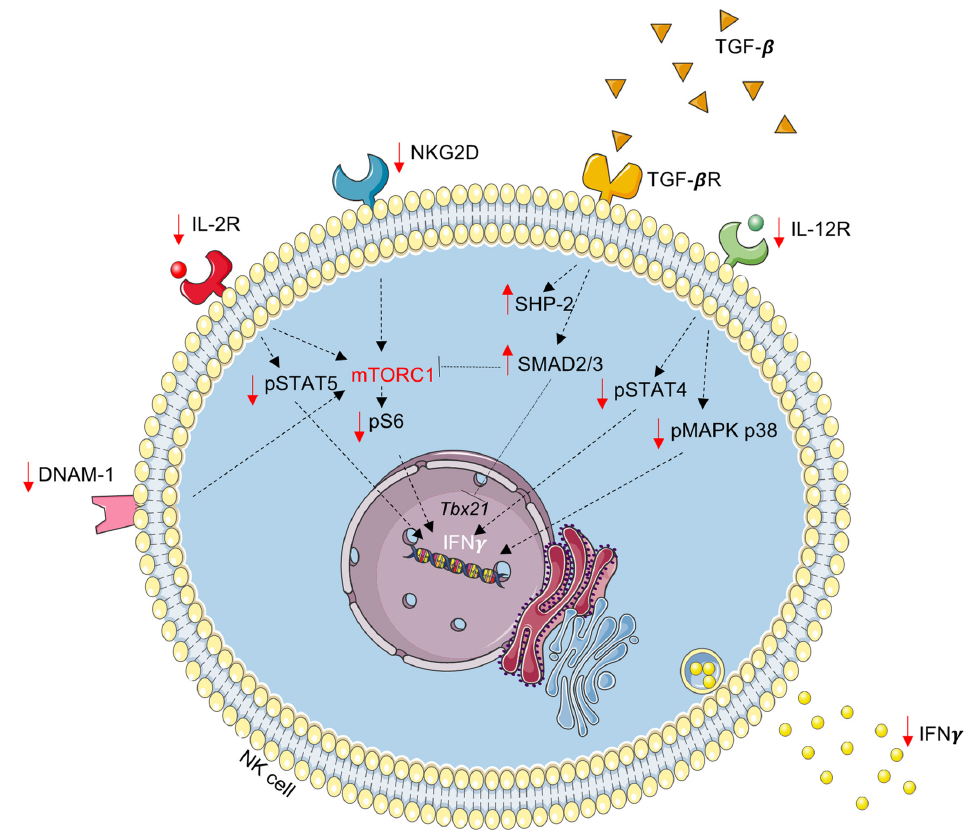
Figure 7. Proposed mechanisms of TGF ‐β‐ mediated Natural Killer cell dysfunction. Upon bind ‐ ing to its receptor, TGF ‐β may signal through SMAD2/3 to directly inhibit the expression of the transcription factor T ‐ bet ( Tbx21 ) or to inhibit mTOR via unknown intermediary protein(s). Smad ‐ independent mechanisms may include the production and activation of SHP ‐ 2 phosphatase, which may indirectly mediate mTOR activity. These changes in intracellular signaling may then contribute to downregulation or activating receptors (IL ‐ 2R, IL ‐ 12R, NKG2D, DNAM ‐ 1). Finally, these pheno ‐ typic changes result in reduced cytokine (IFN γ ) secretion and suppressed NK cell function.